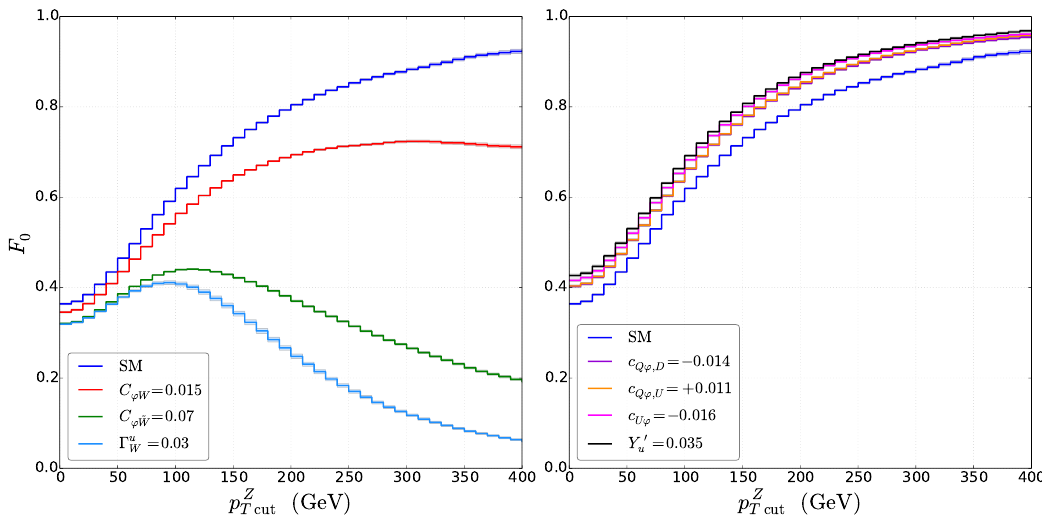
p , at S = 13 TeV. T cut